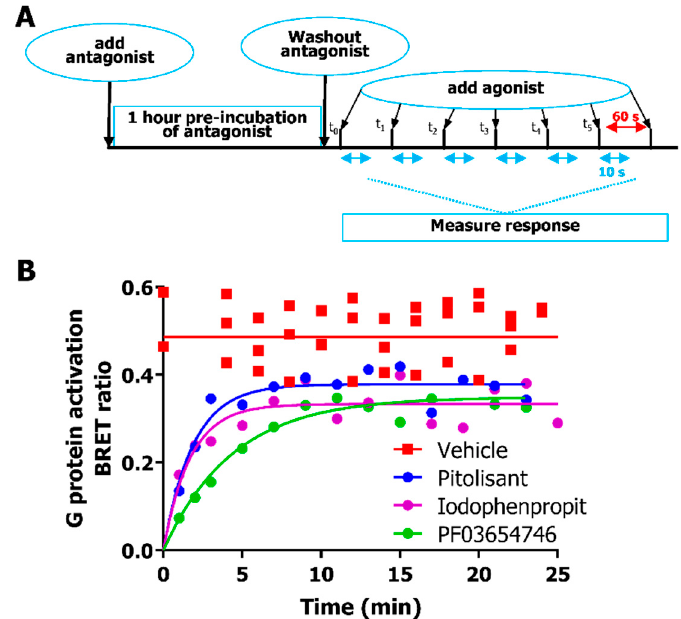
Figure 2. Recovery of hH 3 R-mediated G α i2 activation measured in time as BRET ratio between Venus-G βγ and masGRK3-Nluc after inhibition with antagonists was monitored for 10 s after agonist addition with 60 s time intervals. ( A ) hH 3 R-expressing HEK293T cells were pre-incubated for 1 h with antagonist (10 × IC 50 concentration) followed by rapid washout of unbound antagonist and stimulation with 10 µ M imetit after di ff erent incubation times. ( B ) Recovery rate of hH 3 R responsiveness after washout of pre-bound iodophenpropit, pitolisant and PF03654746BRET ratio’s plotted are calculated 10 s after agonist stimulation. Representative graph of 3 independent experiments performed in singular is shown.